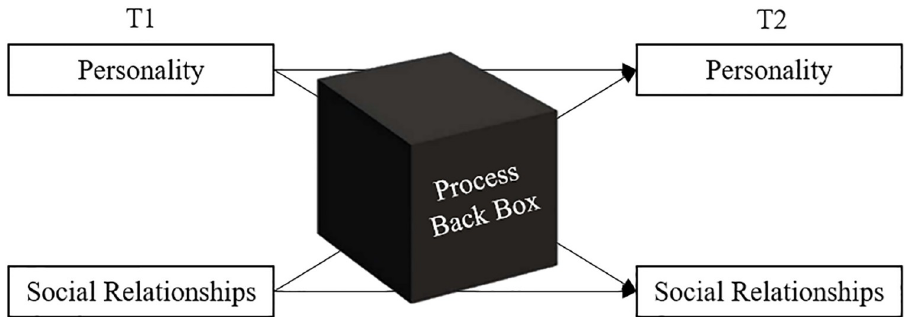
Fig 1. Simplified display of the process black box in the interplay of personality and social relationships over time.